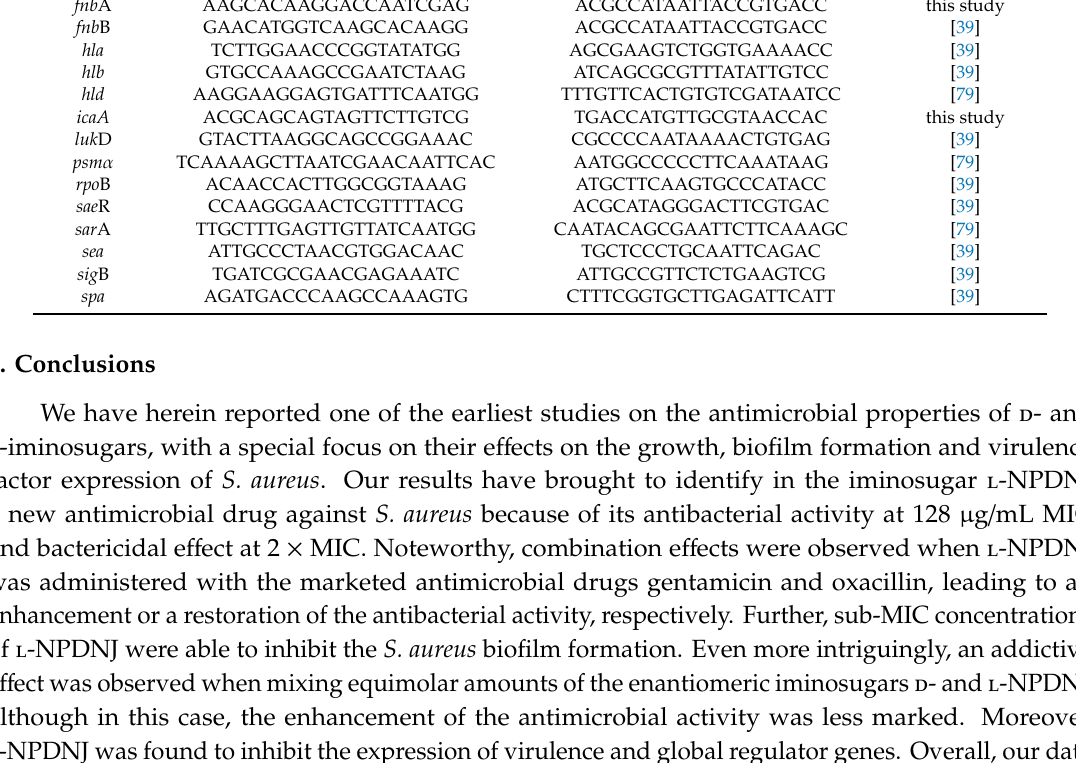
Table S1: Antibiotic susceptibility of clinical isolates used in this study, Table S2: MIC ( µ g / mL) and MBC ( µ g / mL) values of L-NPDNJ for clinical isolates used in this